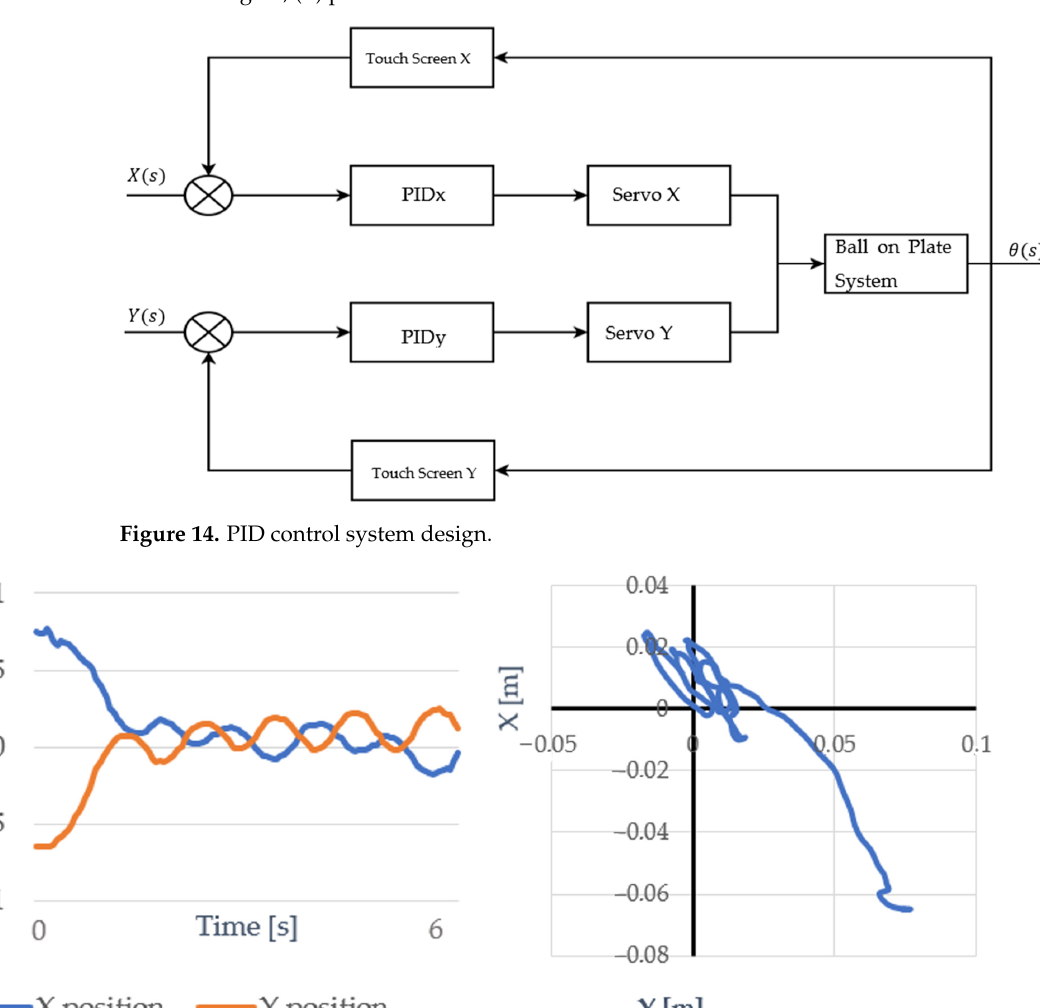
Figure 13. ( a ) Example run: X and Y positions in the real environment using a pre-trained and fine-tuned agent; ( b ) positions in 2 dimensions.